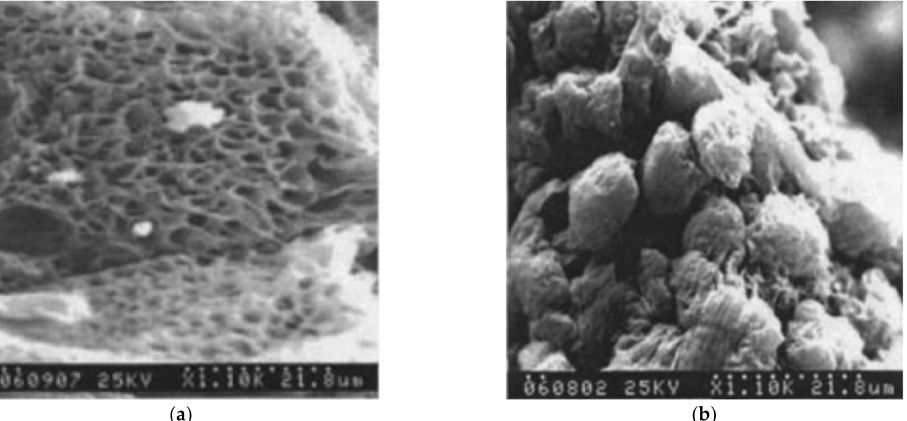
Figure 7. SEM images of capillary-porous bodies prepared by cooling UHMWPE mixtures with ( a ) diphenyl ether and ( b ) decaline containing 40 wt% of the polymer in air. Reproduced with permission from H. Ding, Y. Tian, L. Wang, B. Liu, Journal of Applied Polymer Science; Published by “John Wiley and Sons”,